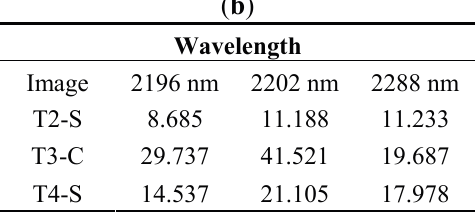
Table 4. Differences between T1-S and successive images (T2-S, T3-C and T4-S) in wavelength position, depth and width of absorption features at 2196 nm, 2202 nm (associated with kaolinite) and 2288 nm (associated with nontonite). ( a ) mean differences; for all parameters. Parameters derived from T1-S were subtracted from each image therefore positive and negative values indicate that a parameter derived from the indicated image was, respectively, greater or smaller than T1-S; ( b ) means absolute